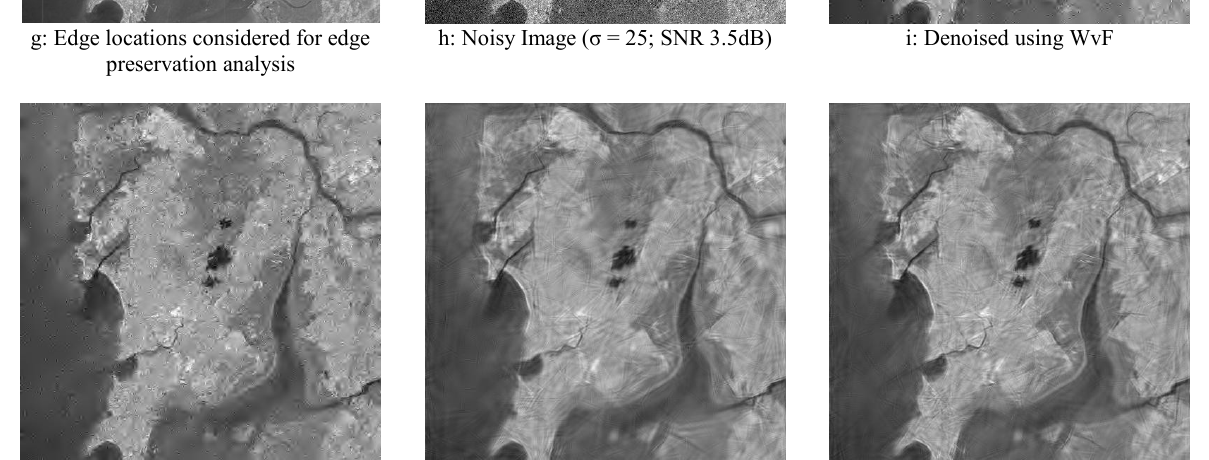
Fig. 6: Denoising of Landsat TM image of